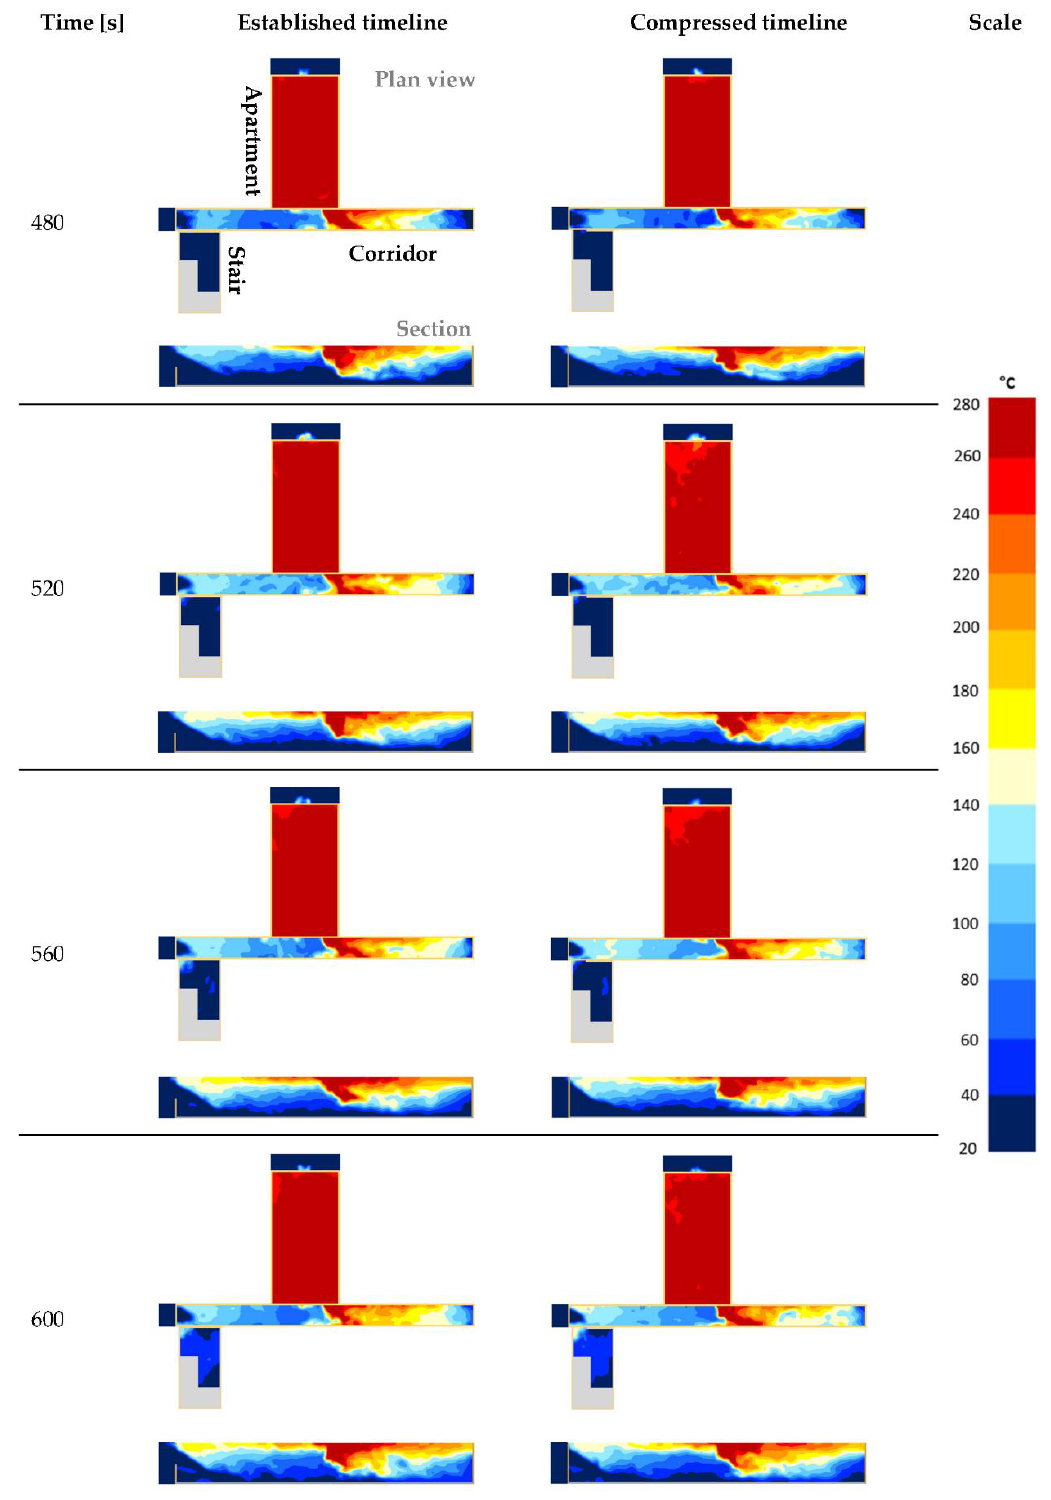
Figure 12. Temperature contour plots for the firefighting phase at z = 1.5 m and through the corridor centreline.